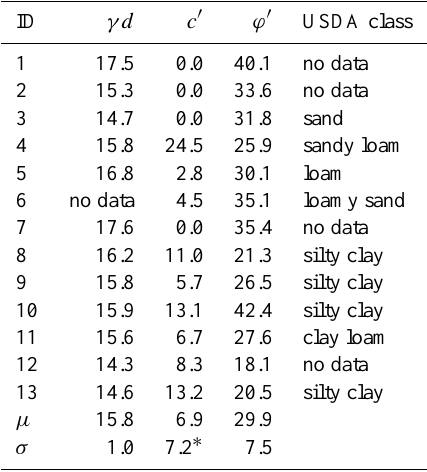
Table 2. Geotechnical key parameters derived for 13 samples from the Collazzone study area (see Fig. 4 for location of the sites). γ d = dry specific weight (kNm − 3 ), c (cid:48) = effective cohesion (kNm − 2 ), ϕ (cid:48) = effective angle of internal friction (degree). Arith- metic mean µ and standard deviation σ are listed.